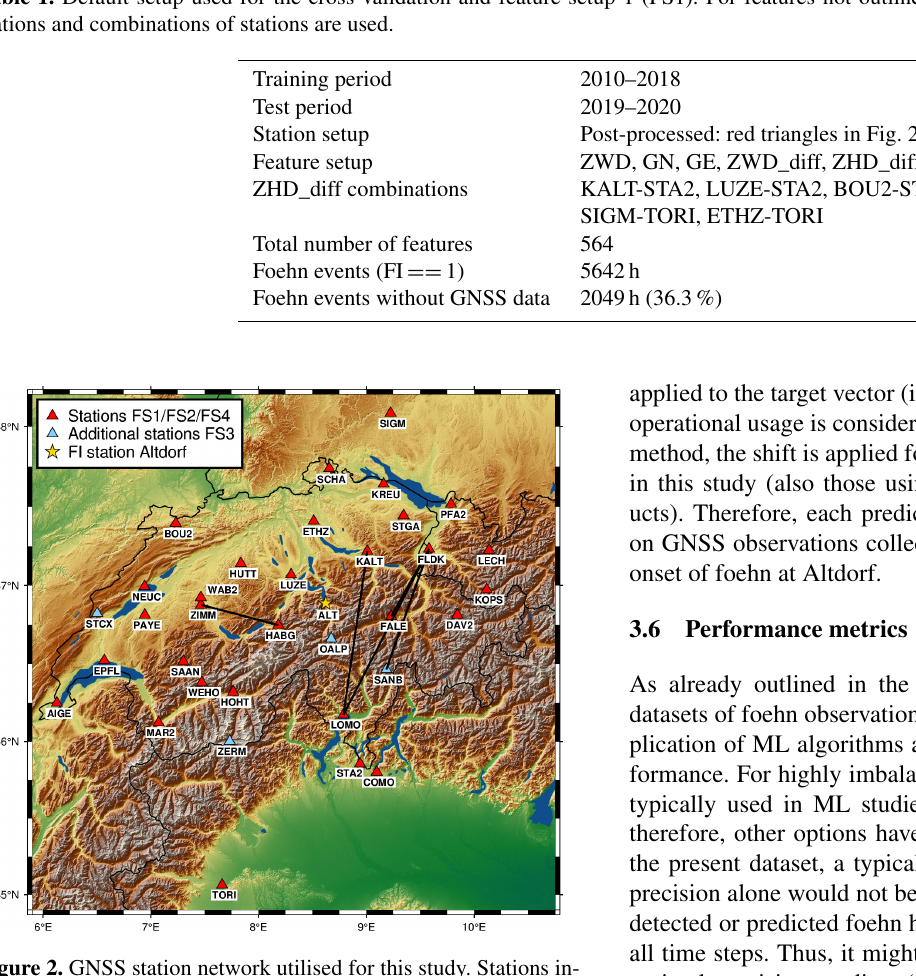
Figure 2. GNSS station network utilised for this study. Stations in- cluded in the default setup (cross-validation and all feature setups) are marked as red triangles. Stations explicitly used in feature setup 3 (FS3) are marked as blue triangles. The SMN station Altdorf is marked with a yellow star. In addition, the black lines represent the ZWD differences between stations, which serve as the top predic- tors in FS3, shown in Sect.